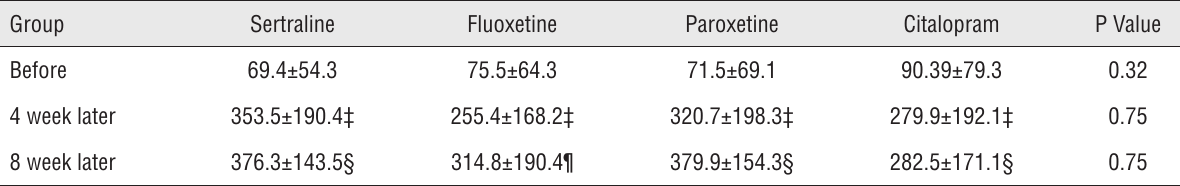
Table 2 - Mean and standard deviation (Second) of IELT* in four groups†. Group Sertraline Fluoxetine Paroxetine Citalopram Before